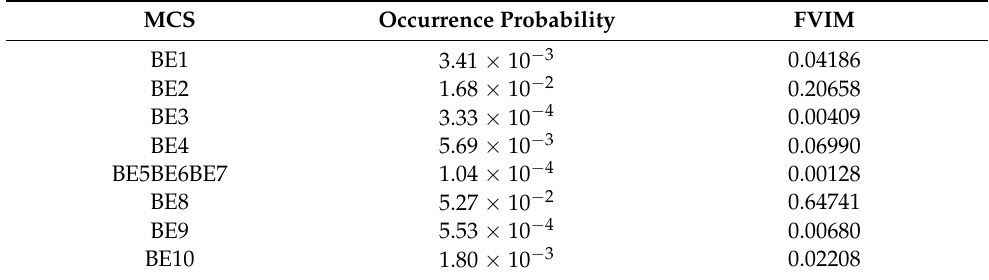
Table 11. Occurrence probability and FVIM